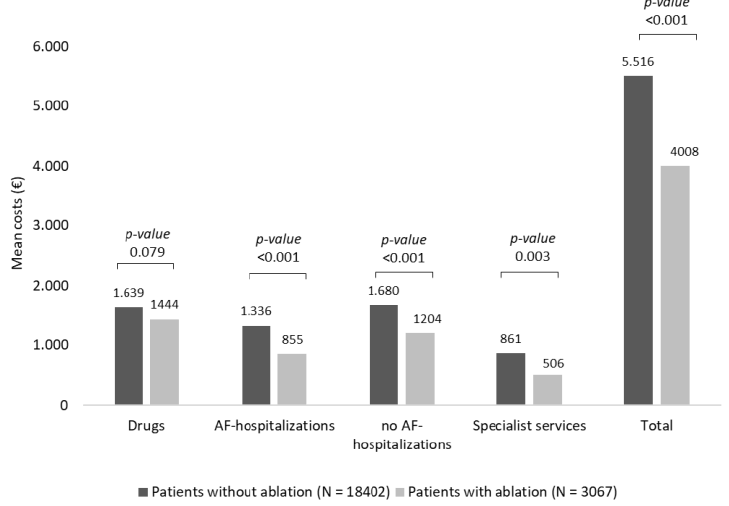
Figure 3. Mean annual healthcare direct costs in AF patients with and without ablation procedure, post PSM.